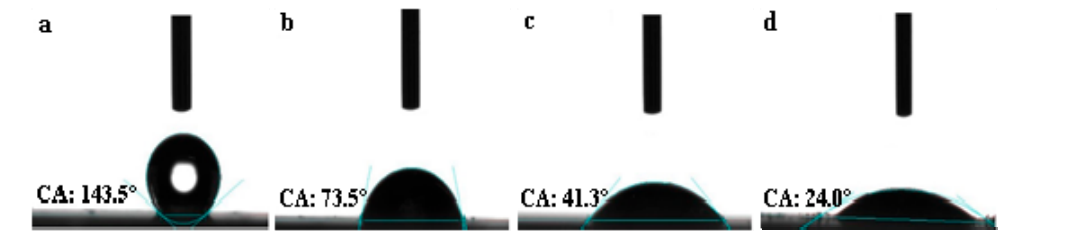
Figure 4. Contact angle pictures of catalysts: ( a ) NPC-900. ( b ) O-NPC-80. ( c ) O-NPC-100. ( d ) O-NPC-120.